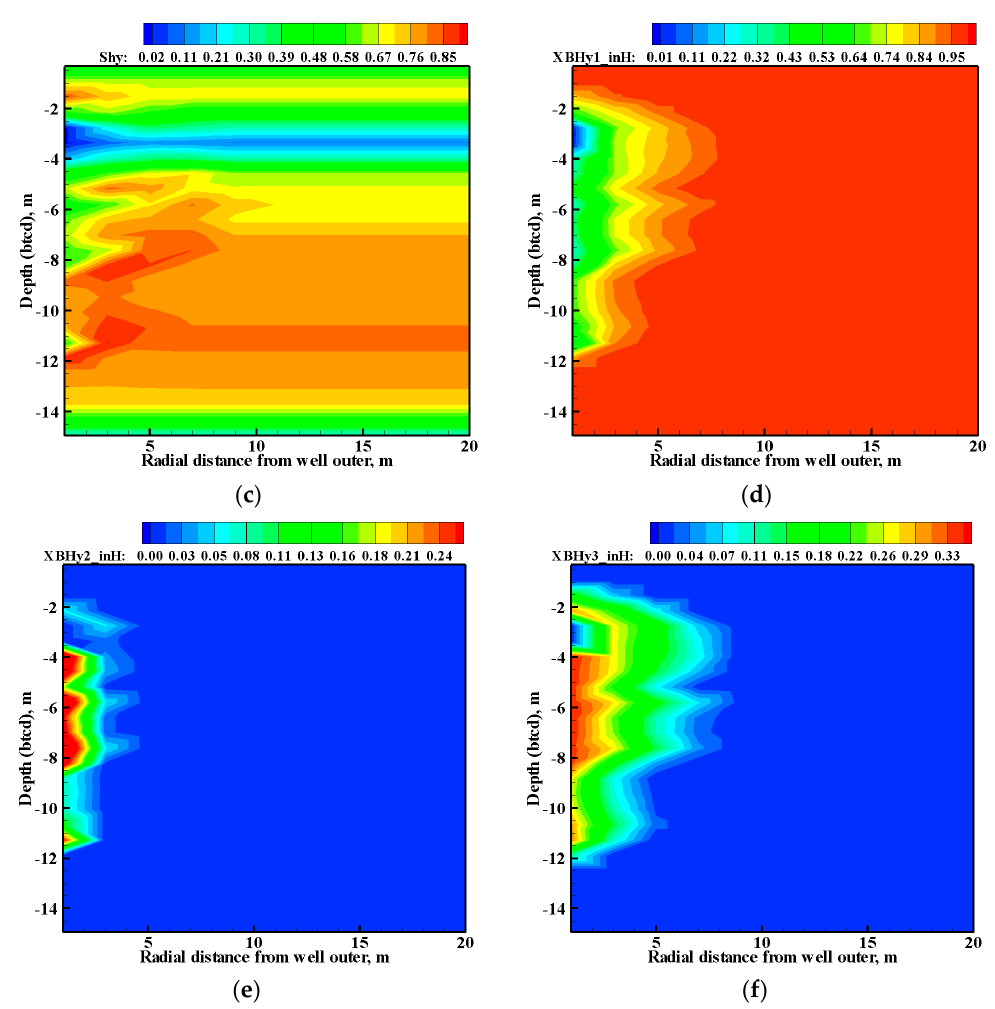
Figure 8. Simulated results at the end of injection. ( a ) Gas phase saturation; ( b ) temperature, °C; ( c ) hydrate phase saturation; ( d ) mass fraction of CH 4 hydrate in the hydrate phase; ( e ) mass fraction of CO 2 hydrate in the hydrate phase; ( f ) mass fraction of N 2 hydrate in the hydrate phase.